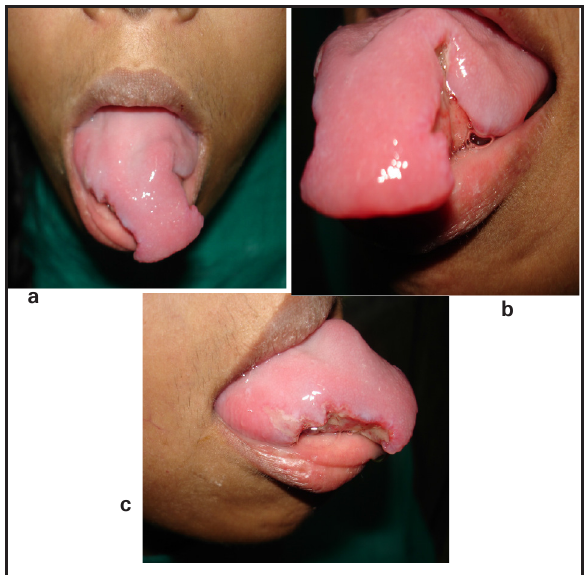
Figure 2. The tongue after application of topical clotrimazole in 1% w/v strength; it appeared deformed, smooth and glistening, without any papilla and resembled the head of a hammerhead shark. The candidial coat has disappeared [2a]. The lateral edges have undergone extensive sloughing, with erosions into the submucosa and musculature. Necrotic debris is seen on the edges and floor of the ulcers [2b,